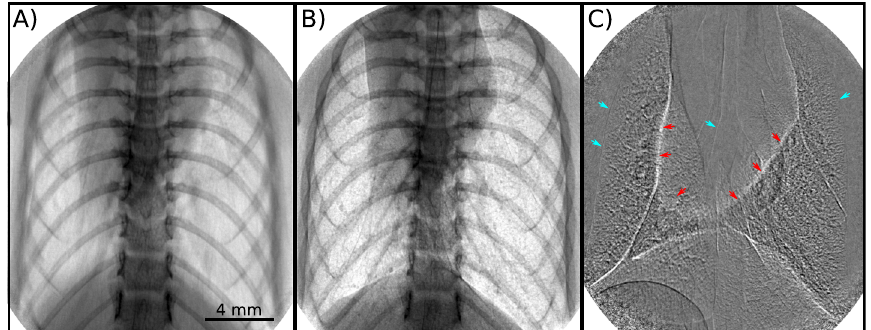
Figure 1. Propagation-based X-ray phase-contrast images of a mouse chest in vivo show the increase in image quality that is possible with sufficient flux to image the lungs without motion blur. In panel (A), an image was captured mimicking the exposure conditions at low-flux X-ray sources, resulting in motion blur due to the required averaging over breath cycles (here: one cycle during the 500 ms exposure). Panel (B) shows the benefit of a high flux source, which enables short exposures during plateaus of mechanical ventilation, in this case a 200 ms exposure triggered at the beginning of a 222 ms peak-inspiration breath-hold. Panel (C) reveals detailed structures in the lungs via a pseudo-differential image, achieved by subtracting sequential 200 ms breath-hold exposures between which there is a slight movement of the lungs and negligible movement of the skeleton. The red arrows highlight the border of the heart and the blue the edges of the lung and airways. The resulting structure seen within the lungs includes the small airways that are not easily seen in Panel